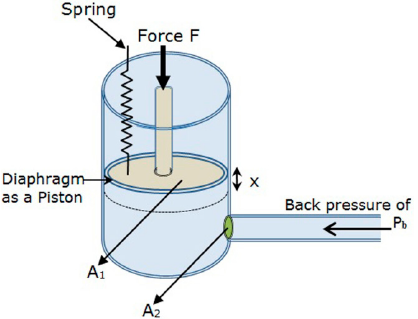
Figure 10. Piston-cylinder model of micropump with